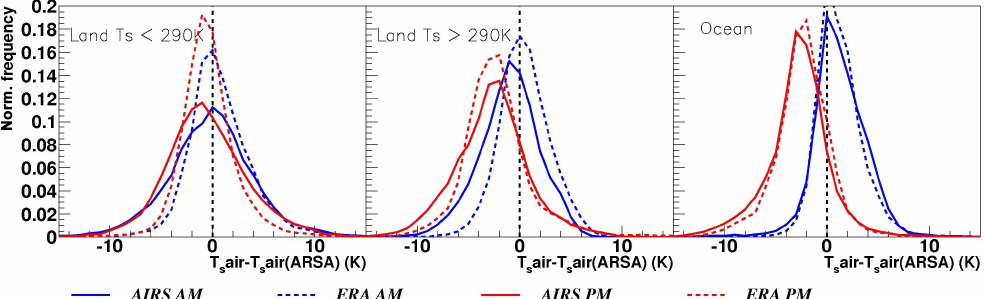
Figure 1. Normalized distributions of the difference between surface skin temperature, as used in the cloud retrieval, deduced from AIRS- NASA of good quality and from ERA-Interim, and collocated surface air temperature of the ARSA database. Statistics includes January and July from 2003–2015, separately over land for colder temperatures ( T surf <290K), over land for warmer temperatures ( T surf >290K) and over ocean.